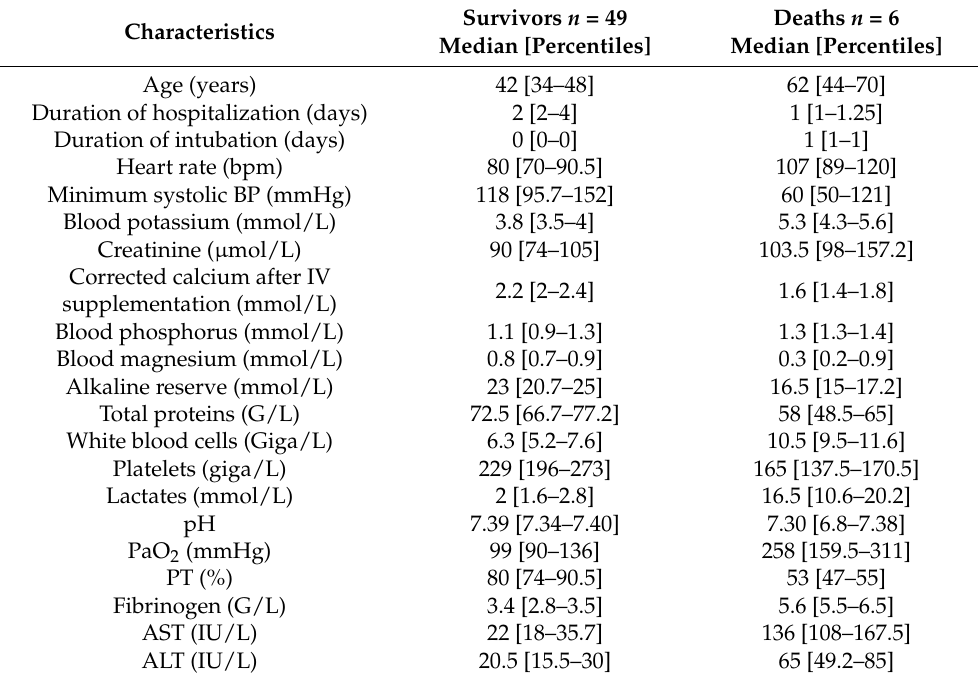
Table 1. Description of the population analyzed.